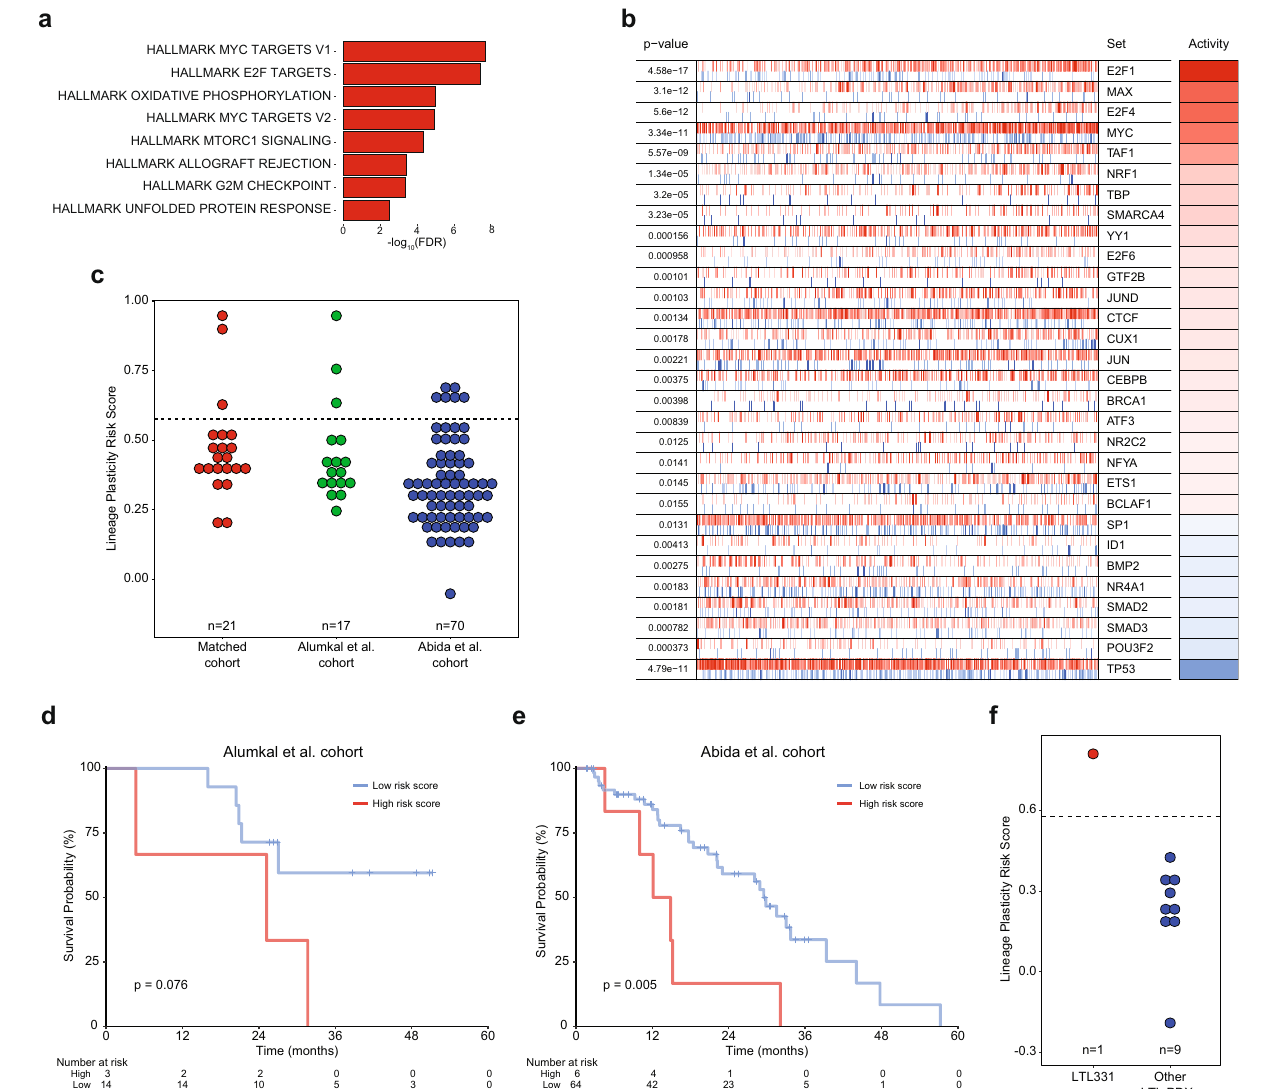
Fig. 3 | Pathway and master regulator analysis implicate E2F1 in lineage plas- ticityrisk,andasignatureoflineageplasticityriskidenti fi estumorswithpoor outcomes after androgen receptor signaling inhibitor treatment. a Hallmark pathway analysisof activated pathwaysin baselinesamples forthe three patients whose tumors converted (underwent lineage plasticity) vs. those patients whose tumors did not upon progression. b Master regulator analysis identi fi es top activated and deactivated transcription factors between converters and non- converters using the baseline tumor samples. Activity scores (right) and p-values (left, calculated using a gene shuf fl ing test of the enrichment scores) were